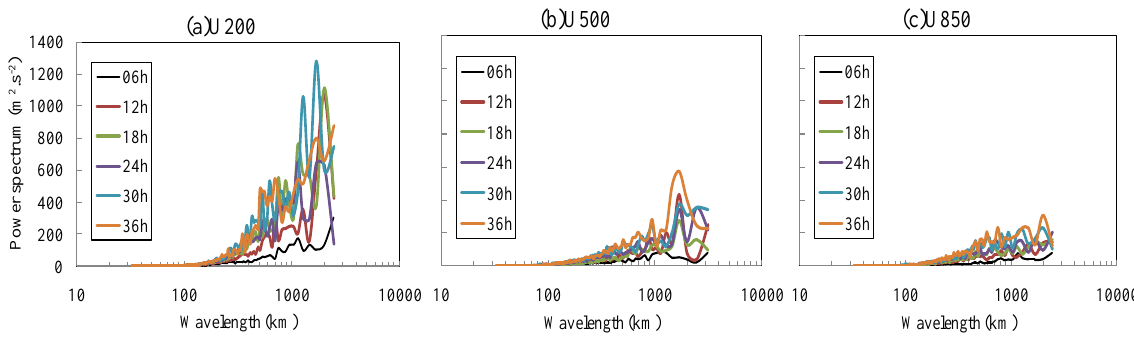
Figure 5. Forecast error power spectra as a function of wavelength at different forecast lead times: ( a ) U200, ( b ) U500, and ( c ) U850.